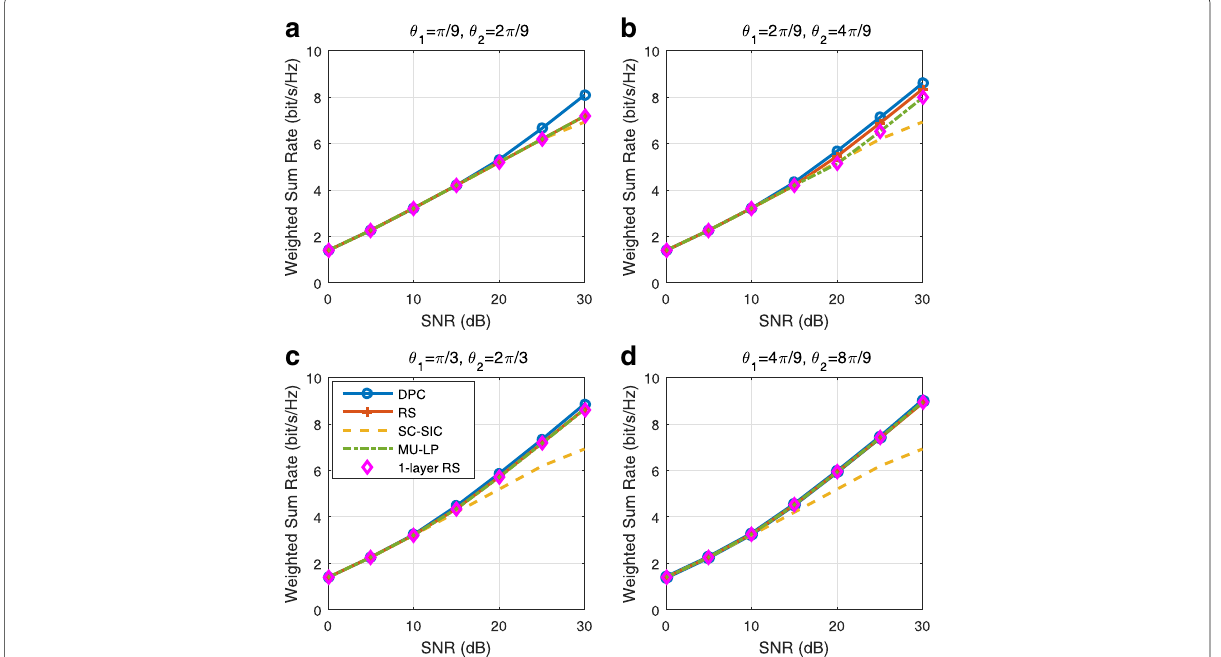
Fig.38 WeightedsumrateversusSNRcomparisonofdifferentstrategiesforunderloadedthree-userdeploymentwithperfectCSIT, γ 1 = 0.3, γ 2 = 0.1,